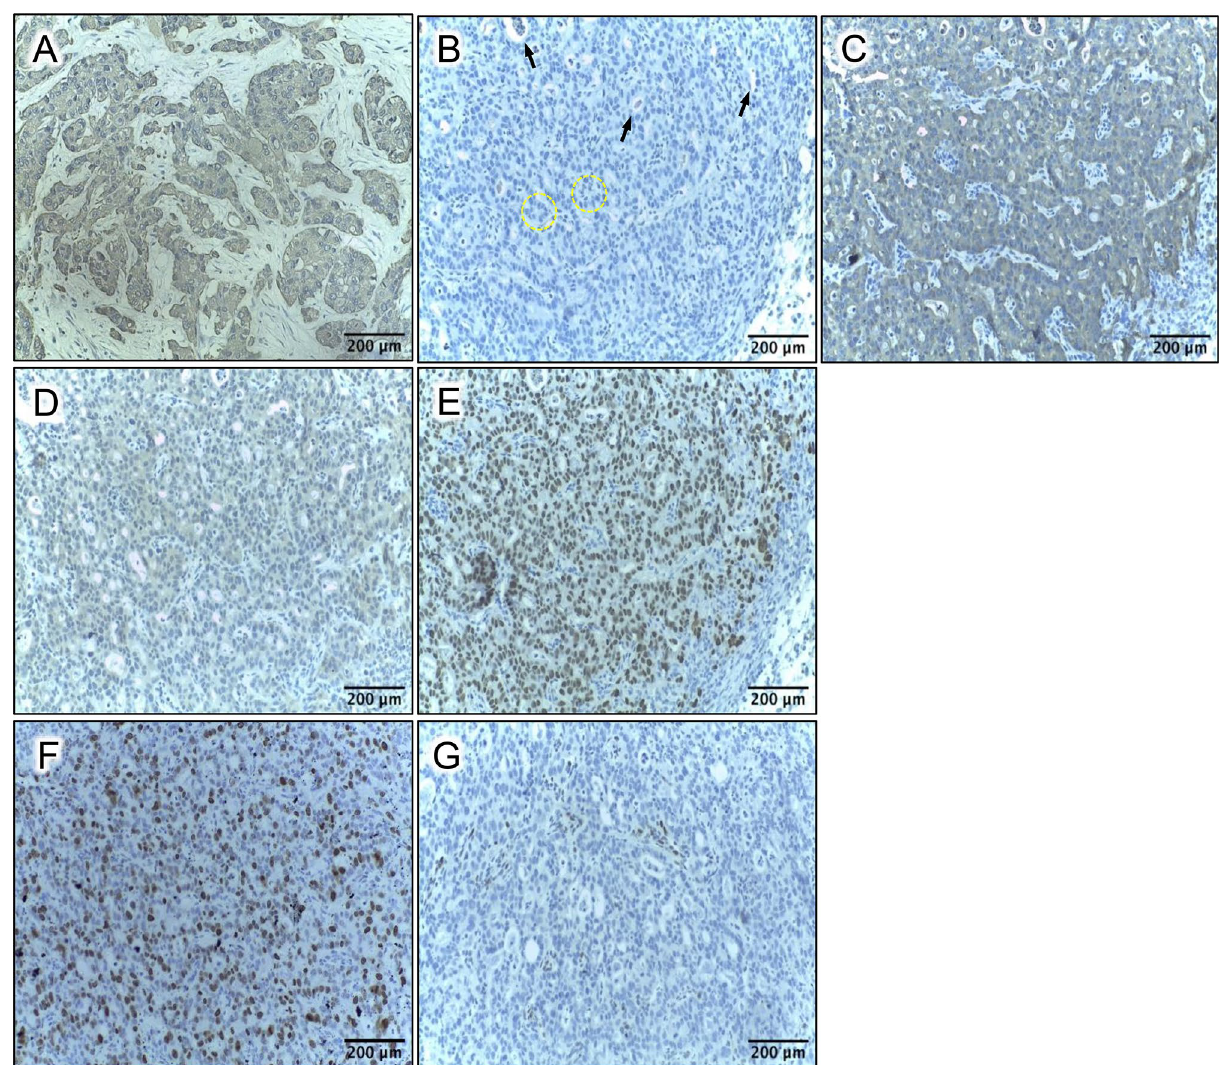
Figure 4. Immunohistochemistry of tumor xenografts from subcutaneous nude mouse assay. ( A ) Pan- Keratin; section from human PDAC (original tumor, not a xenograft); utilized as a positive control (nuclear counterstain = hematoxylin). Panels B-G are all from xenograft tumor, obtained with implantation of the SV40T LV-GK CL2 cell line. ( B ) Negative control (all reagents except no primary antibody). Black arrows = ductal-like structures; dashed yellow circles = acinar-like structures. ( C ) Pan-Keratin. ( D ) KRAS G12D (antibody specific to mutant KRAS). ( E ) SV40T. ( F ) Ki-67. ( G )